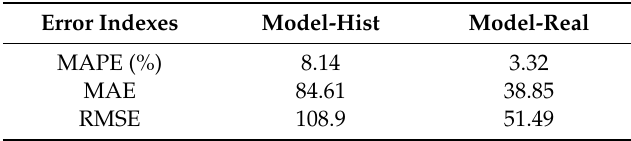
Table 6. Comparative experiment for the historical data model and the real-time data model. Error Indexes Model-Hist